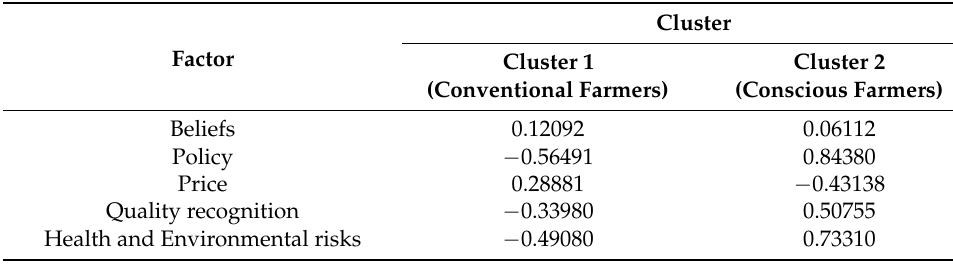
Table 5. Final cluster